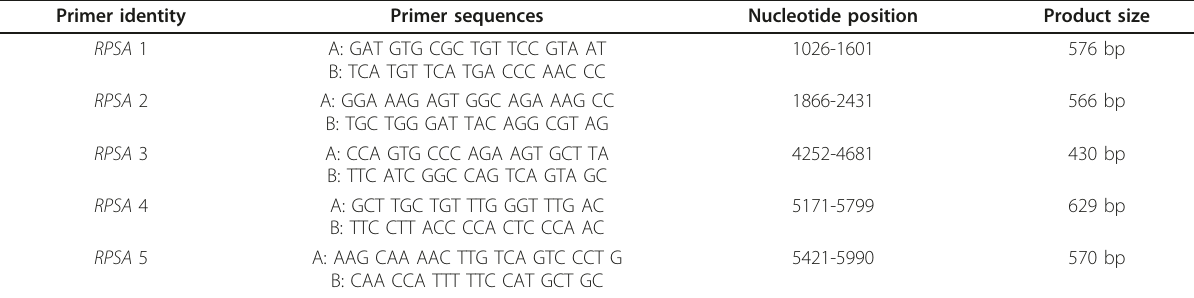
Table 2 PCR primers used to screen the